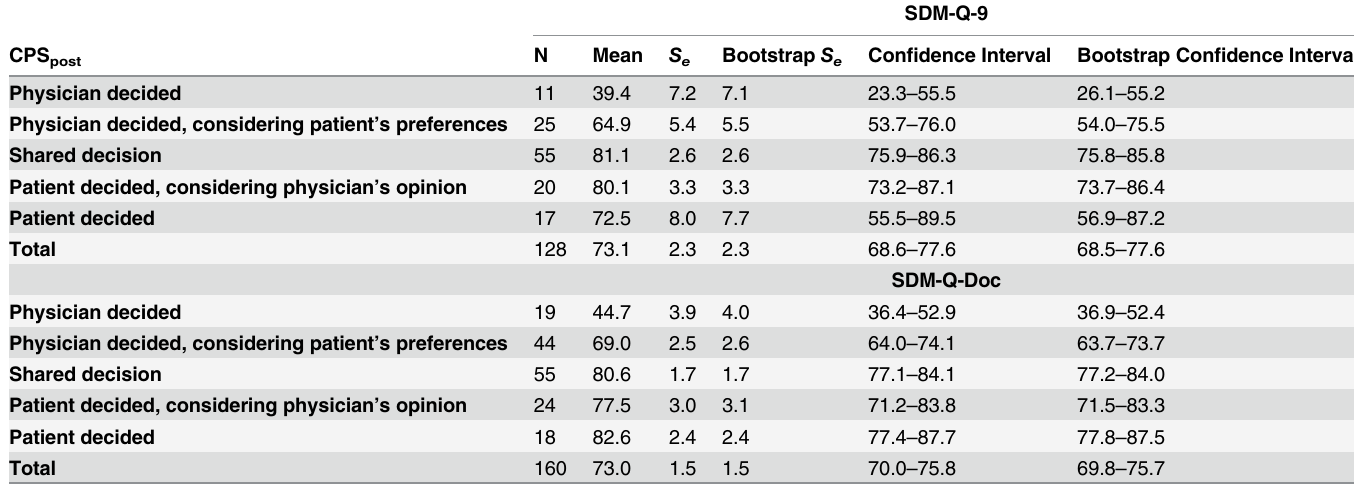
Table 5. Means and confidence intervals for assessing the convergent validity of the SDM-Q-9 and SDM-Q-Doc using the CPS post